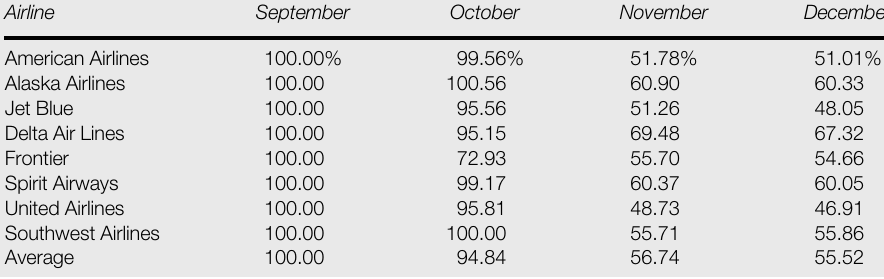
Table 2 Planned vs actual scheduled capacity in 2020